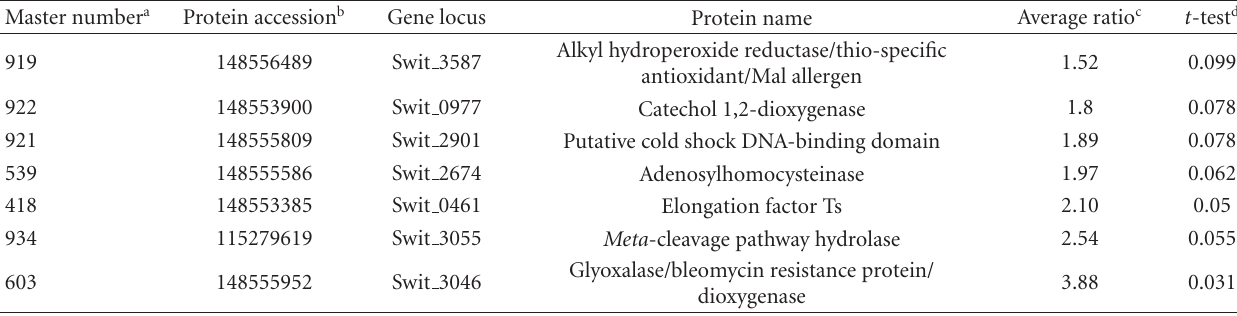
Table 1: Proteins identified as being increased in S. wittichii RW1 during growth on dibenzofuran when compared to growth on acetate. The spots were identified on a minimum of 6 gel images.